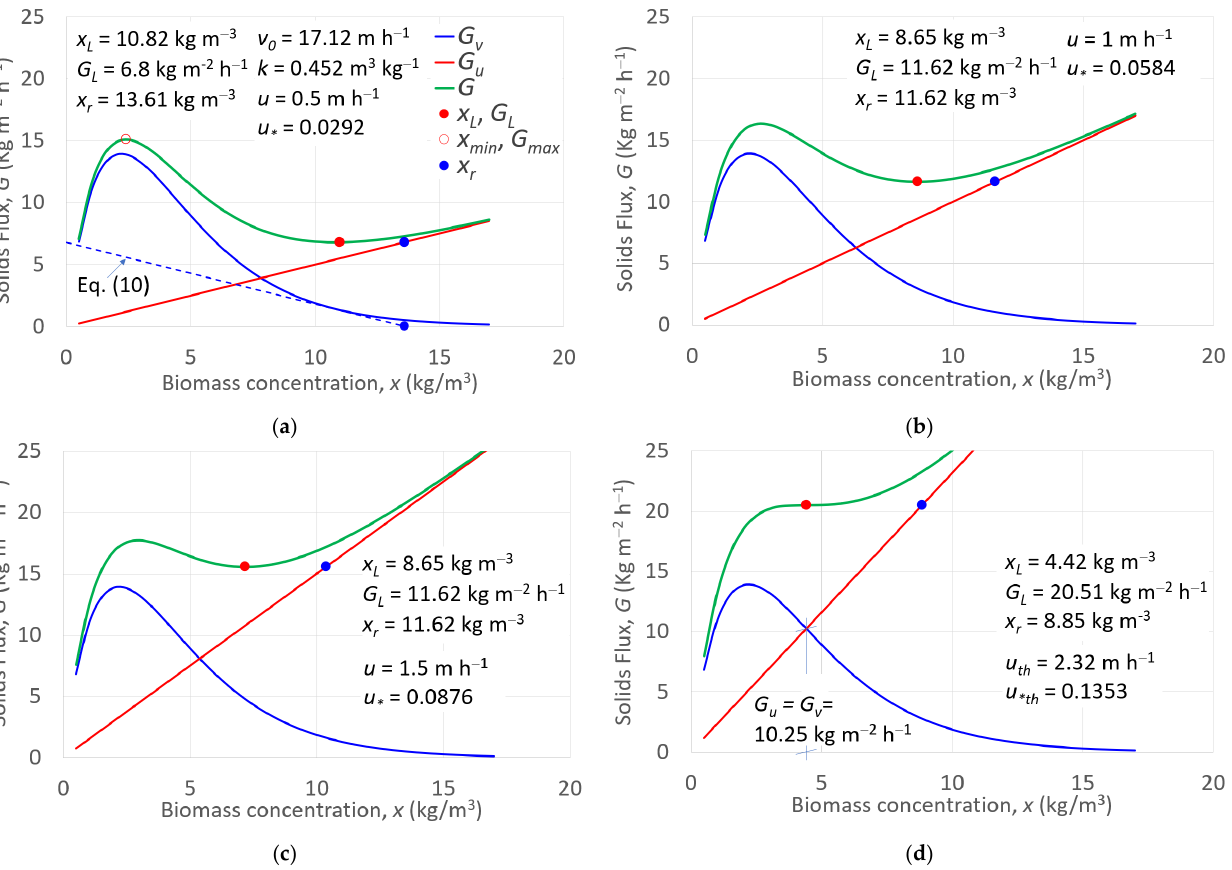
Figure 1. Solids flux contributions due to gravity, G v , and the activated sludge extraction, G u , and their sum G (Equation (1)) versus the biomass concentration, x , for ( a ) u = 0.5 m h − 1 , ( b ) u = 1 m h − 1 , ( c ) u = 1.5 m h − 1 , and ( d ) u = u th = 2.32 m h − 1 . The limiting SS concentration, x L ; the corresponding solid flux, G L ; and the SS concentration of the recycle flow rate, x r , are also indicated.